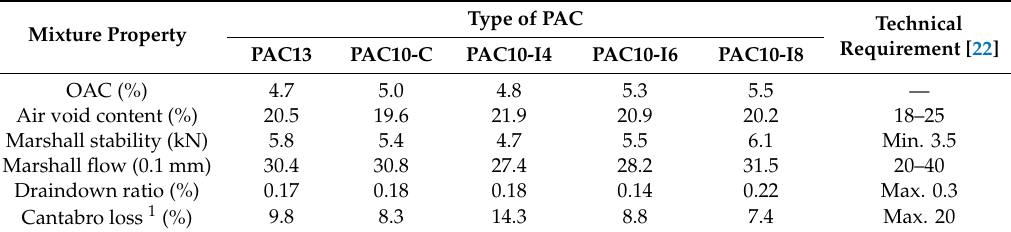
Table 5. Mix design property results of PAC.